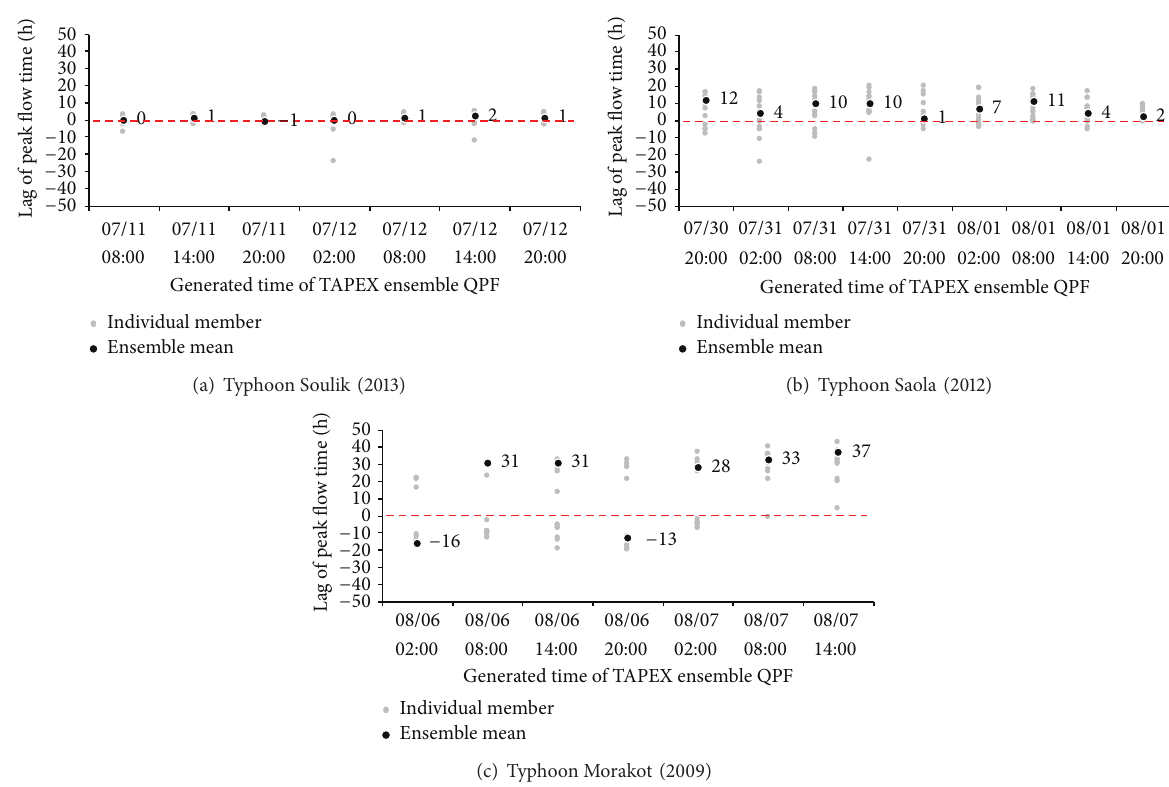
Figure 8: The error of peak flow forecast in timing. The averages of the ensemble-mean forecast error were 0.57, 6.78, and 18.71h in time lag.